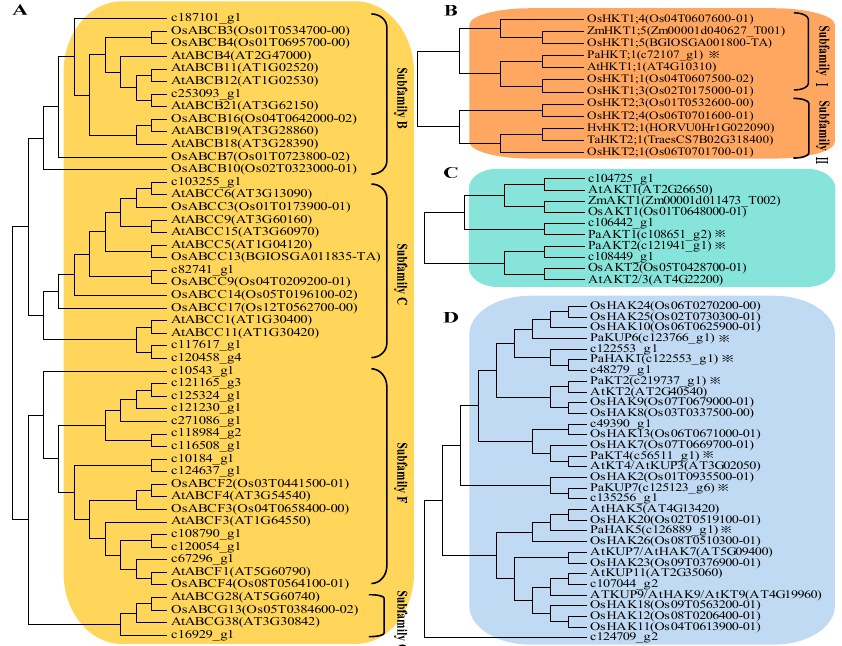
Figure 5. Phylogenetic analysis and nomenclature of target gene. ( A ) Phylogenetic analysis of ABC transporter family. ( B ) Phylogenetic analysis of HKT family. ( C ) Phylogenetic analysis of AKT family. ( D ) Phylogenetic analysis of HAK/KT/KUP family.